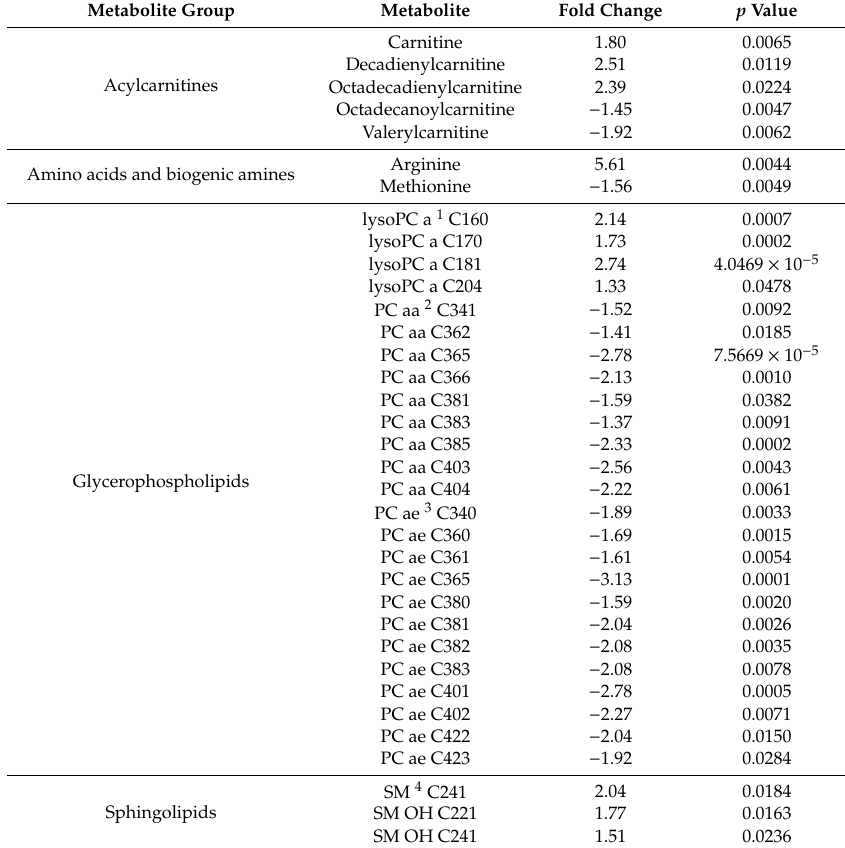
Figure 1. Statistical results of targeted metabolomics in hair samples from drug-free controls ( n = 12) and heavy MA abusers ( n = 10). ( a ) Principal component analysis (PCA) score plot. Red circle: drug-free controls; green circle: heavy MA abusers. ( b ) Volcano plot; red circle: metabolites with significance at p < 0.05 and fold change > 1.2 or < − 1.2. ( c ) Partial least squares discriminant analysis (PLS-DA) score plot. Red circle: drug-free controls; green circle: heavy MA abusers. ( d ) Variable importance on projection (VIP) score plot. Colored box: relative concentration in drug-free controls and heavy MA abusers; ( e ) Venn diagram integrating results from the t -test, VIP scores, and receiver-operator characteristic (ROC) curves. Table 3. Significantly changed metabolites in the hair samples from heavy MA abusers.